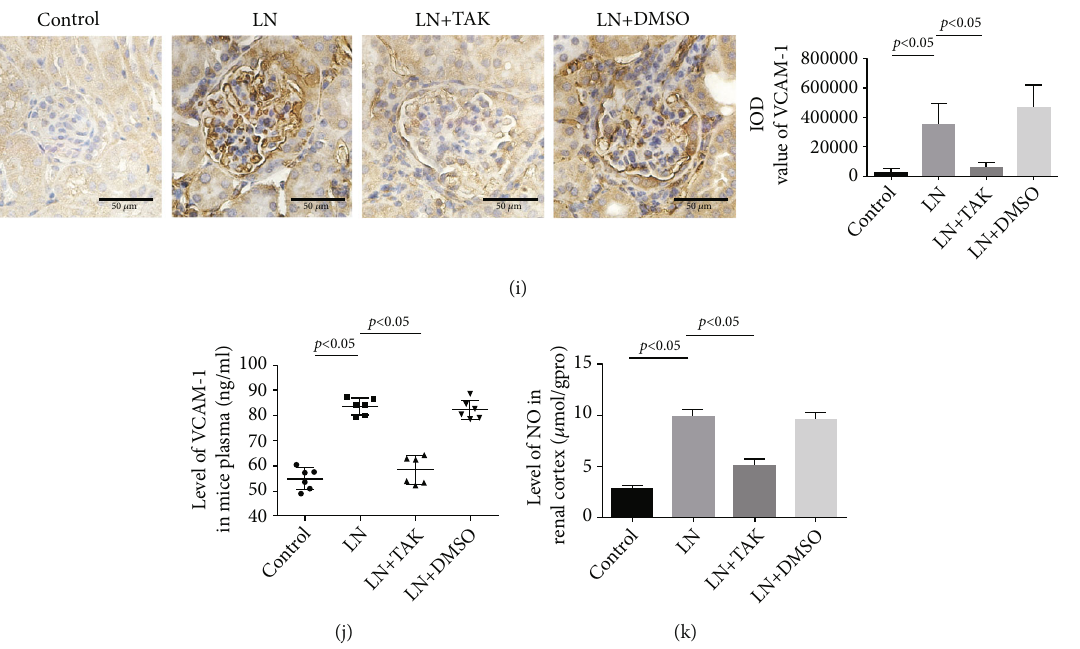
Figure 7: TAK242 alleviated the GEC injury in MRL/lpr mice. (a) IF staining of TLR4 (red) and CD31 (green) in the renal glomeruli cells of control and LN groups. (b) IF staining of MyD88 (red) and CD31 (green) in the renal glomeruli cells of control and LN groups. (c) IHC of NF- κ B/p65 in the renal glomeruli cells of control and LN groups. (d) IF staining of MyD88 (red) and CD31 (green) in the renal glomeruli cells of mice. (e) IHC of NF- κ B/p65 in the renal glomeruli of mice. (f) TEM showed the glomerular endothelial glycocalyx of mice. (g) The level of SDC-1 in mouse plasma detected by ELISA. (h) IF staining of SDC-1 (red) and CD31 (green) in the renal glomeruli cells of mice. (i) IHC of VCAM-1 in the mouse renal glomeruli cells of mice. (j) The level of VCAM-1 in the mouse plasma assessed by ELISA. (k) The level of NO in the renal cortex of mice. ∗ p < 0 : 05 vs. control group. GEC: glomerular endothelial cell; TAK: